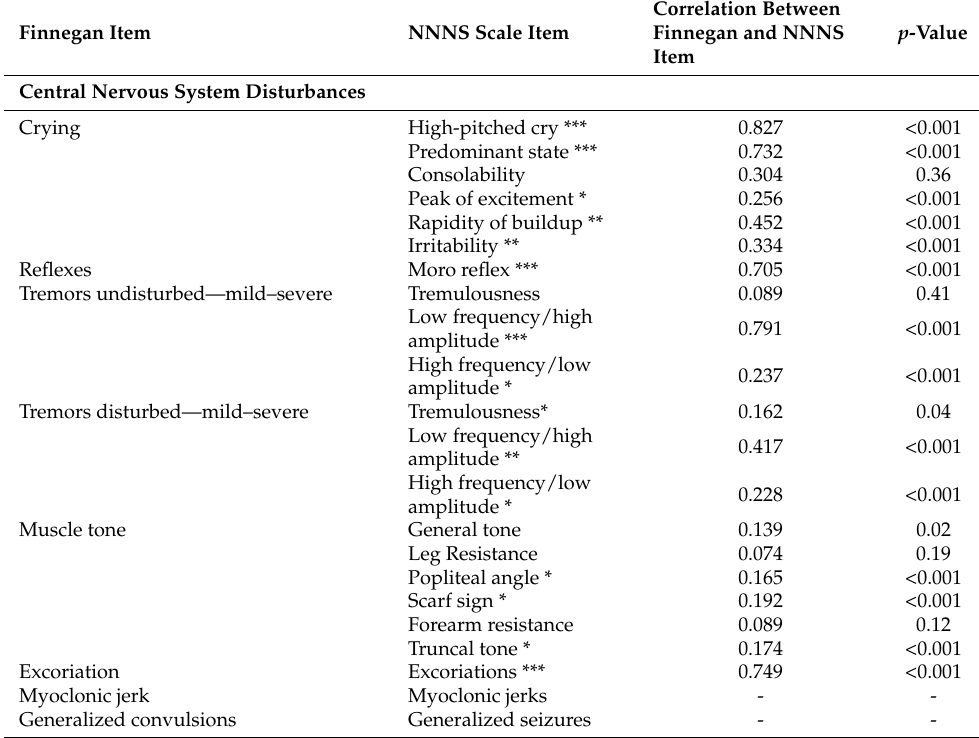
Table 2. Correlations between Finnegan and NNNS